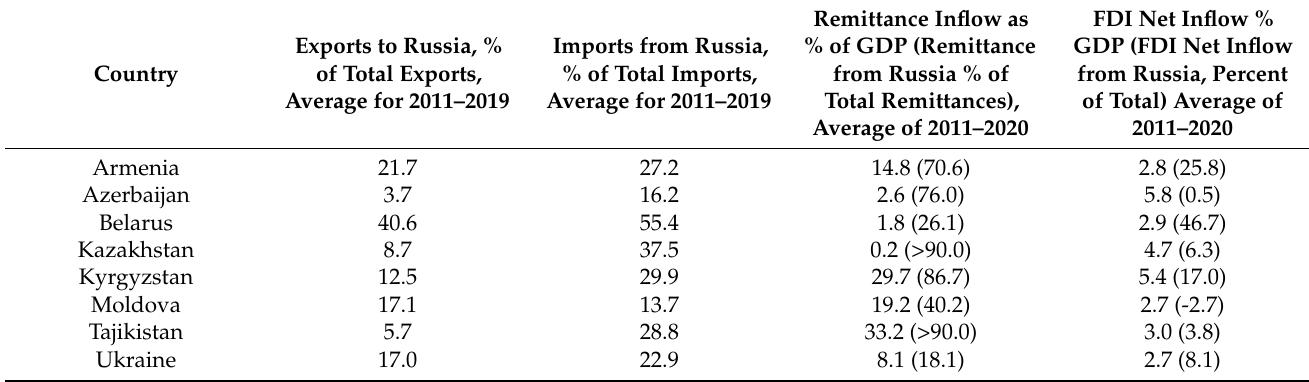
Table 2. Interconnectedness of CIS Countries with the Russian